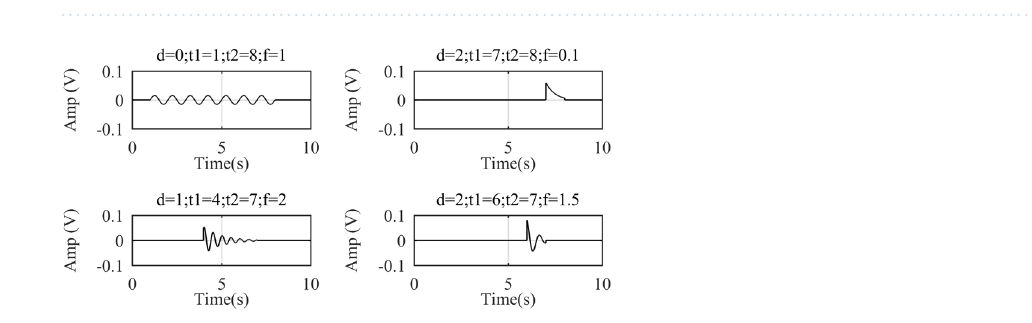
Table 1. Results analysis of different methods. The ideal search results are [0, 0] and ideal solution is 0.